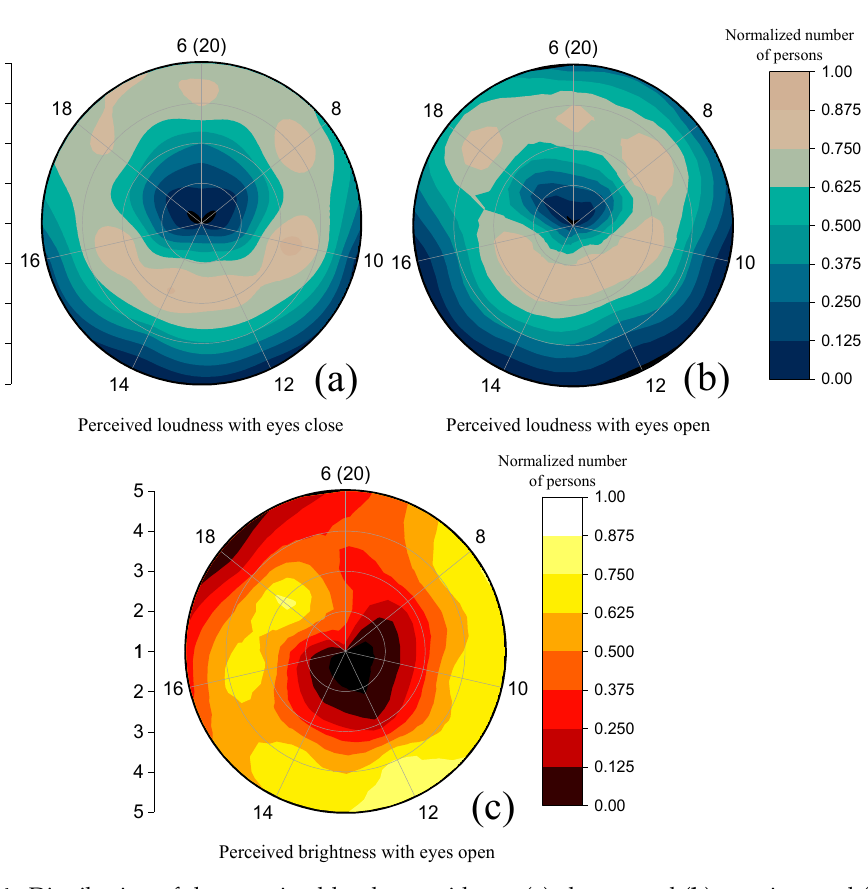
Figure 4. Distribution of the perceived loudness with eye ( a ) closure and ( b ) opening, and ( c ) the distribution of perceived brightness with eyes open from 6:00 to 20:00.